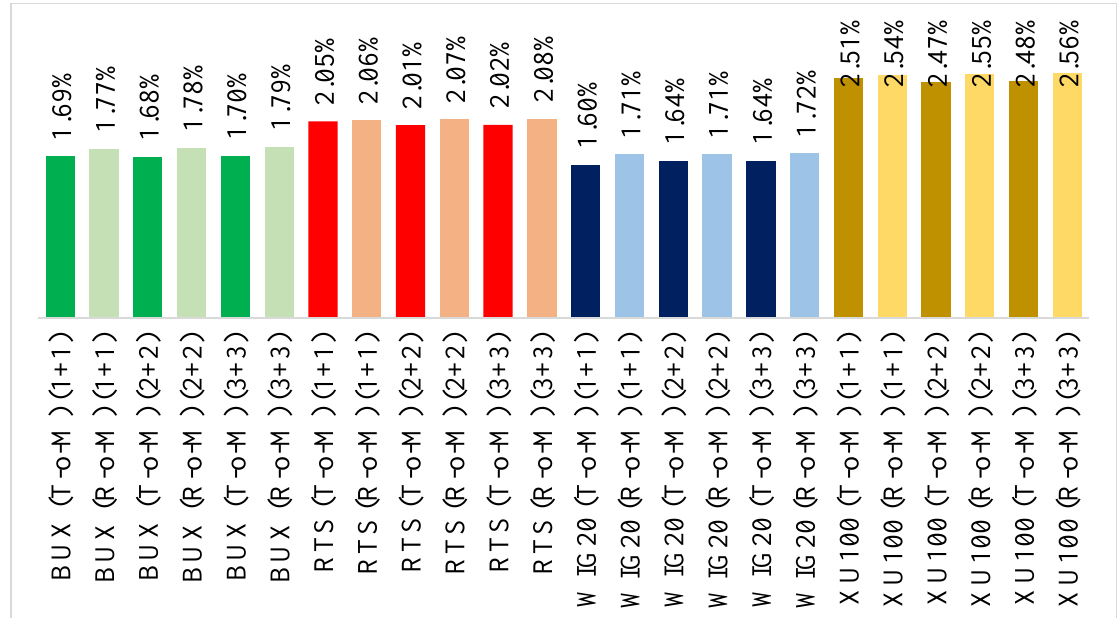
Figure 4. Comparison of average daily volatilities (alternative 1).